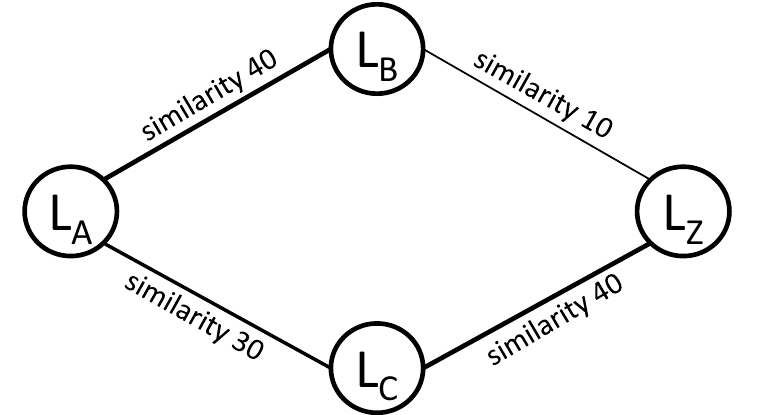
Figure 1. Example of language similarity